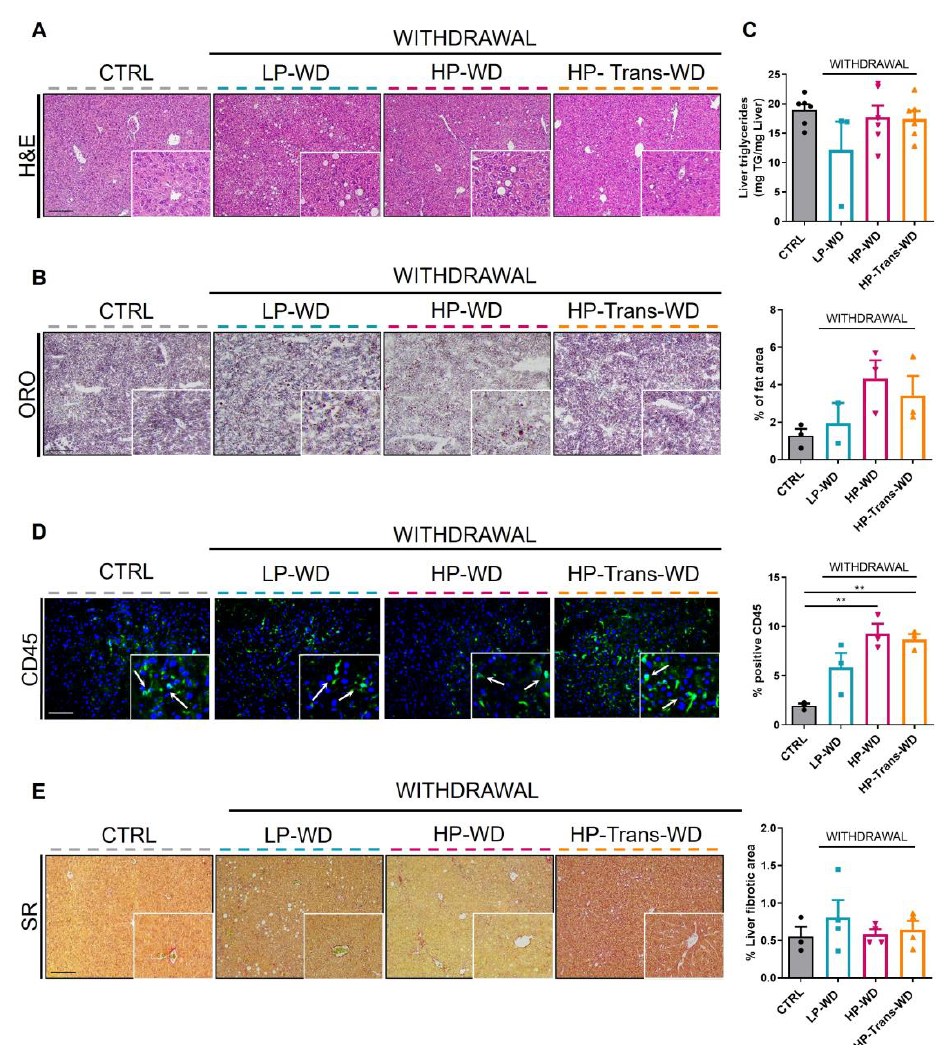
Figure 7. Effects of WD withdrawal on steatohepatitis and fibrosis. ( A ) H and E staining of liver sections from each group. Scale bar = 100 µ m (n = 3–6). ( B ) Representative Oil Red O staining of liver cryosections after WD diet withdrawal. Scale bar = 100 µ m (n = 3–6). ( C ) Quantification of hepatic TG after diet withdrawal. ( D ) IF staining for CD45. The number of CD45 positive cells (green, arrows) was quantified and calculated as percentage of total cells (DAPI, blue). Scale bar = 100 µ m (n = 3). ( E ) SR staining and quantification of positive areas after withdrawal of WD. Scale bar = 100 µ m (n = 3–6). ** p < 0.01.